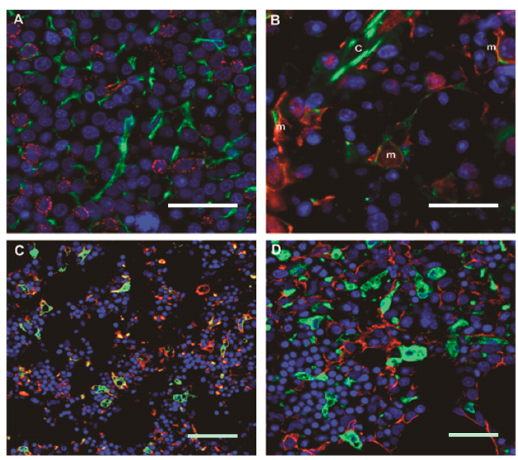
Figure 3. Human bone marrow microenvironment: CD271+ mesenchymal stromal cells form a delicate arborizing reticular network that is enriched around vasculature, are in contact with the majority of CD34+ hematopoietic progenitor/stem cells, and coexpress the chemokine CXCL12. Bone marrow iron is stored within HO1-expressing CD163+ macrophages, which are also in contact with CD271+